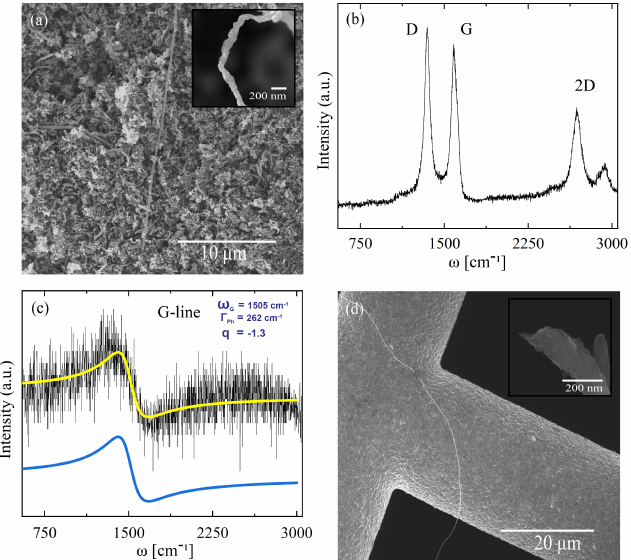
Figure 9. ( a ) SEM micrograph from pristine GNRs as obtained from the CVD process. A wide bundle of ribbons are evinced in widths of around 100 nm and lengths higher than 10 microns; ( b ) Raman spectra of pristine graphene nanoribbons. Characteristic GNRs features are present. The double resonance single 2D-line component around 2700 cm − 1 indicates the presence of a graphene-like ribbon structure; ( c ) Raman spectrum of graphene nanoribbon intercalation compounds (GNRIC) in a KC 8 stoichiometry. The Fano-like line shape derived from the strong coupling between K atoms and the graphene is a fine characteristic of a stage I intercalation compound; ( d ) Individualized GNRs after potassium intercalation. The structure and shape of the GNRs was not affected after the intercalation as observed in the micrograph. GNRs were confirmed to be longer than 10–20 microns with a width ∼ 100–200